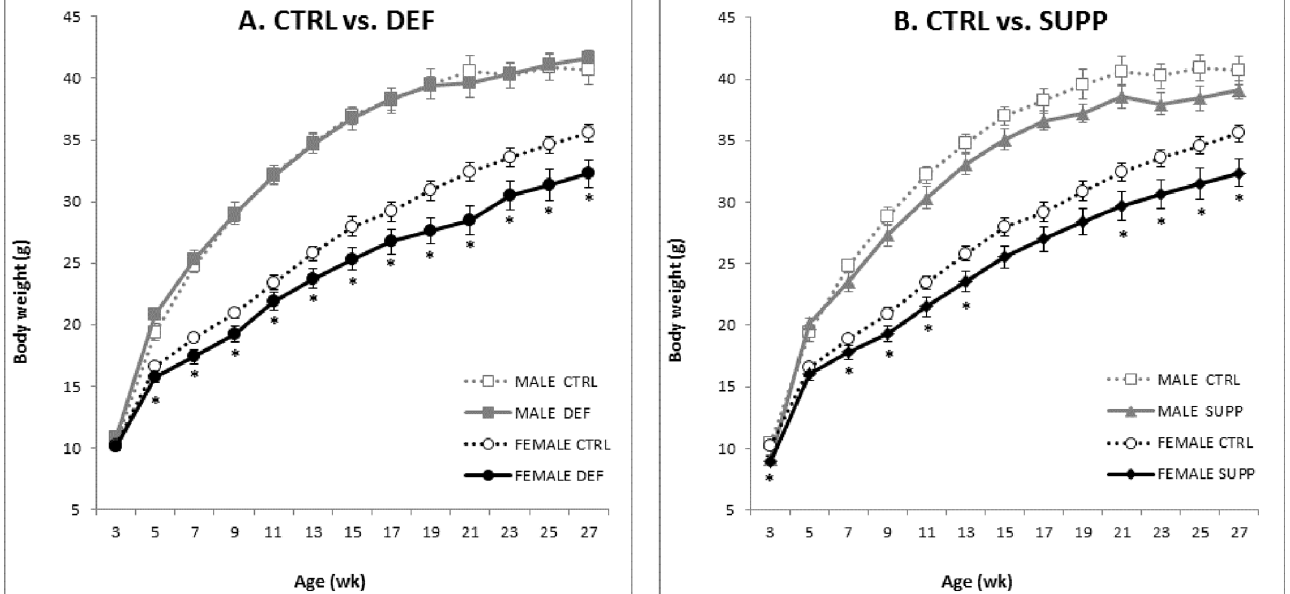
Fig 2. Body weight of Apc 1638N offspring of fathers fed diets differing in B vitamin content. A) Body weight of DEF compared to CTRL offspring, by sex. B) Body weight of SUPP compared to CTRL offspring, by sex. Repeated-measures ANOVA for paternal diet effect p = 0.64 and 0.02 in males and female offspring respectively. Paternal diets: DEF, B-vitamin deficient; CTRL, B-vitamin replete; SUPP, B-vitamin supplemented. * denotes significant difference (in females) compared to CTRL (p (cid:3) 0.05) by t-test. n = 14 – 22 per